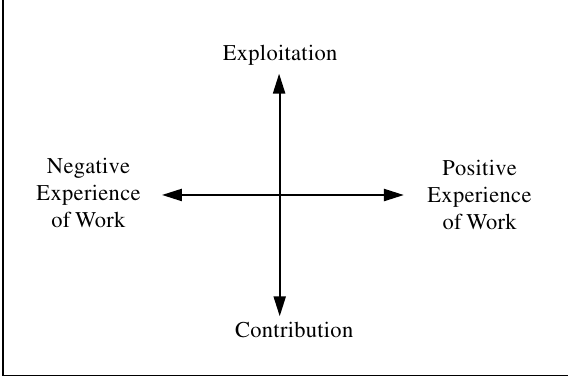
Figure 1 . Children’s subjective experience of work